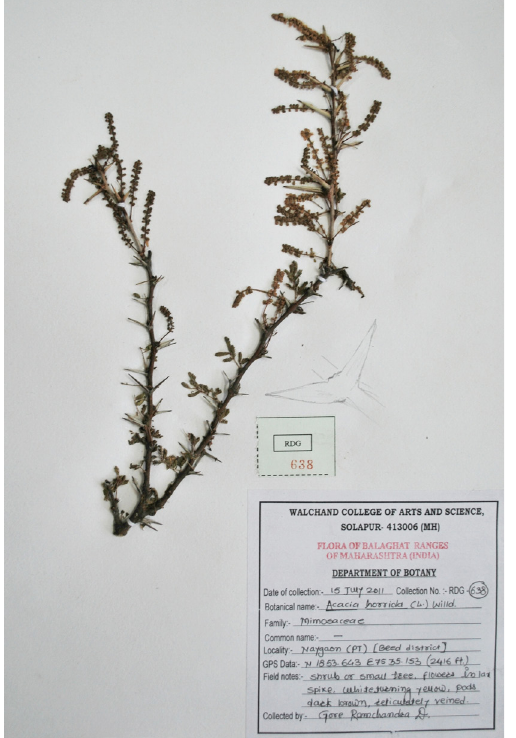
Image 4. Herbarium of Acacia horrida (L.)